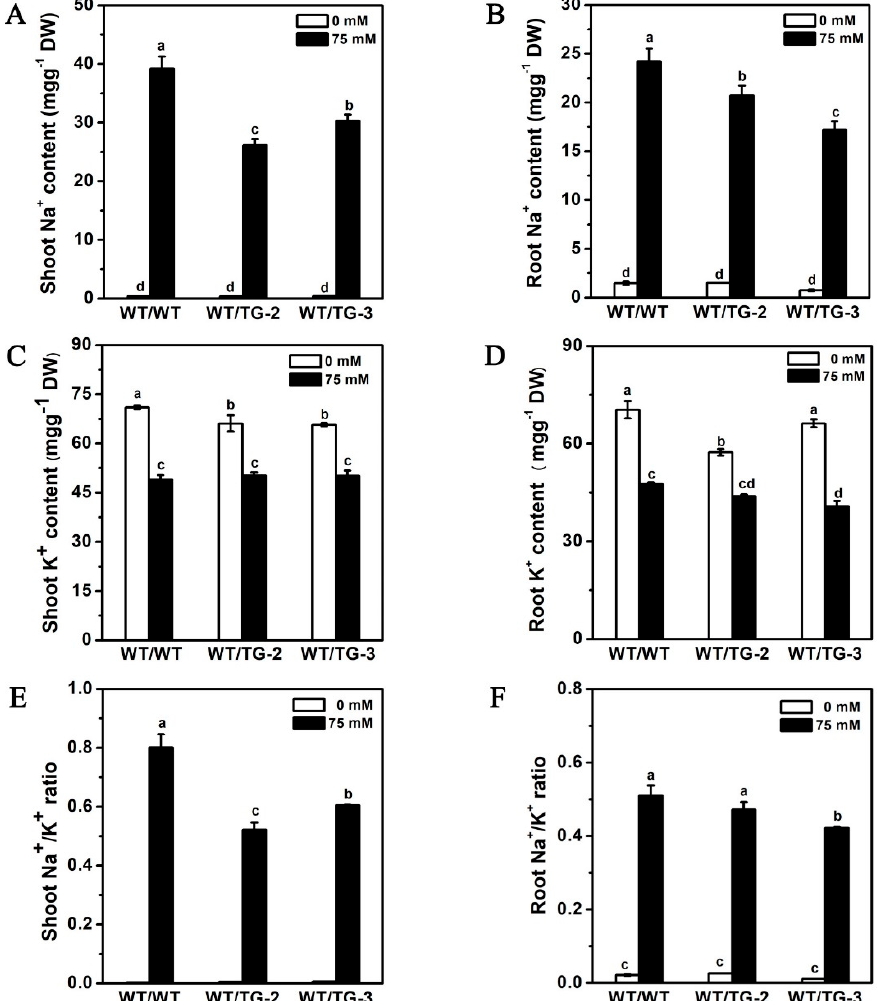
Figure 9. Shoot and root Na + /K + content in control and NaCl-treated grafted seedlings with transgene CmHKT1;1 cucumber as rootstock. Grafted cucumber seedlings cultivated in hydroponics with 75 mM NaCl for 7 days. Shoot Na + content ( A ), K + content ( C ), and Na + /K + ratio ( E ). Root Na + content ( B ), K + content ( D ), and Na + /K + ratio ( F ). WT, wild type. TG, transgene CmHKT1;1 cucumber. WT/WT, WT as the scion and rootstock; WT/TG, WT as the scion, TG as the rootstock. Each value is the mean of three replications ± standard error of the means. Columns with different letters indicate they